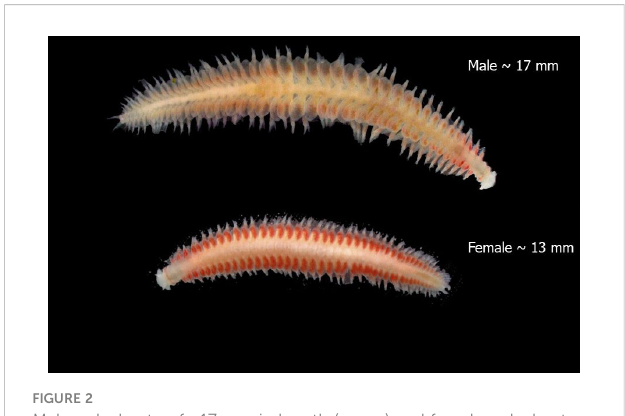
FIGURE 2 Male polychaete of ~17 mm in length (upper) and female polychaete of ~13 mm in length